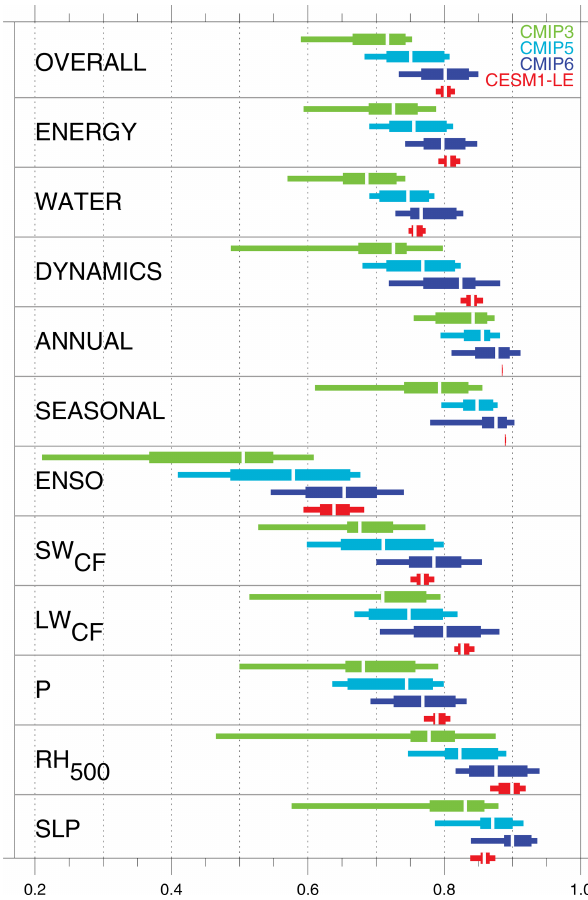
Figure 10. Evolution of the distribution of aggregate and selected variable scores across the CMIP archives and the